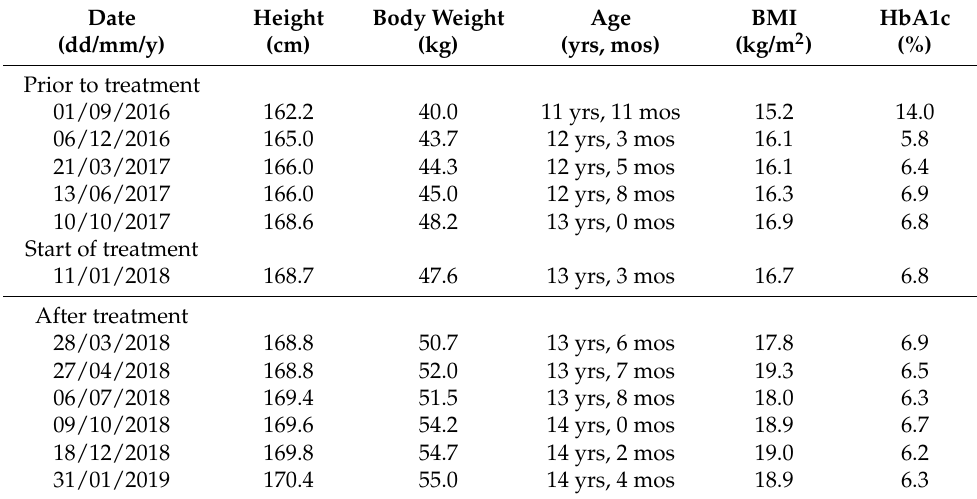
Table 1. The scores of BMI and HbA1c before and after